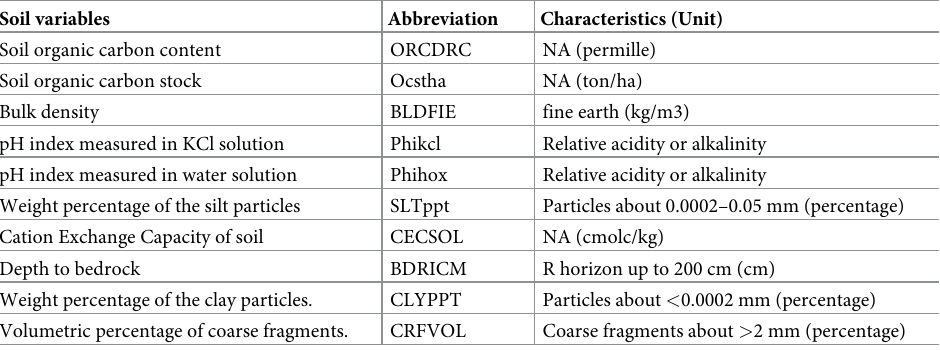
Table 2. Soil variables used with their abbreviation, characteristics and unit of